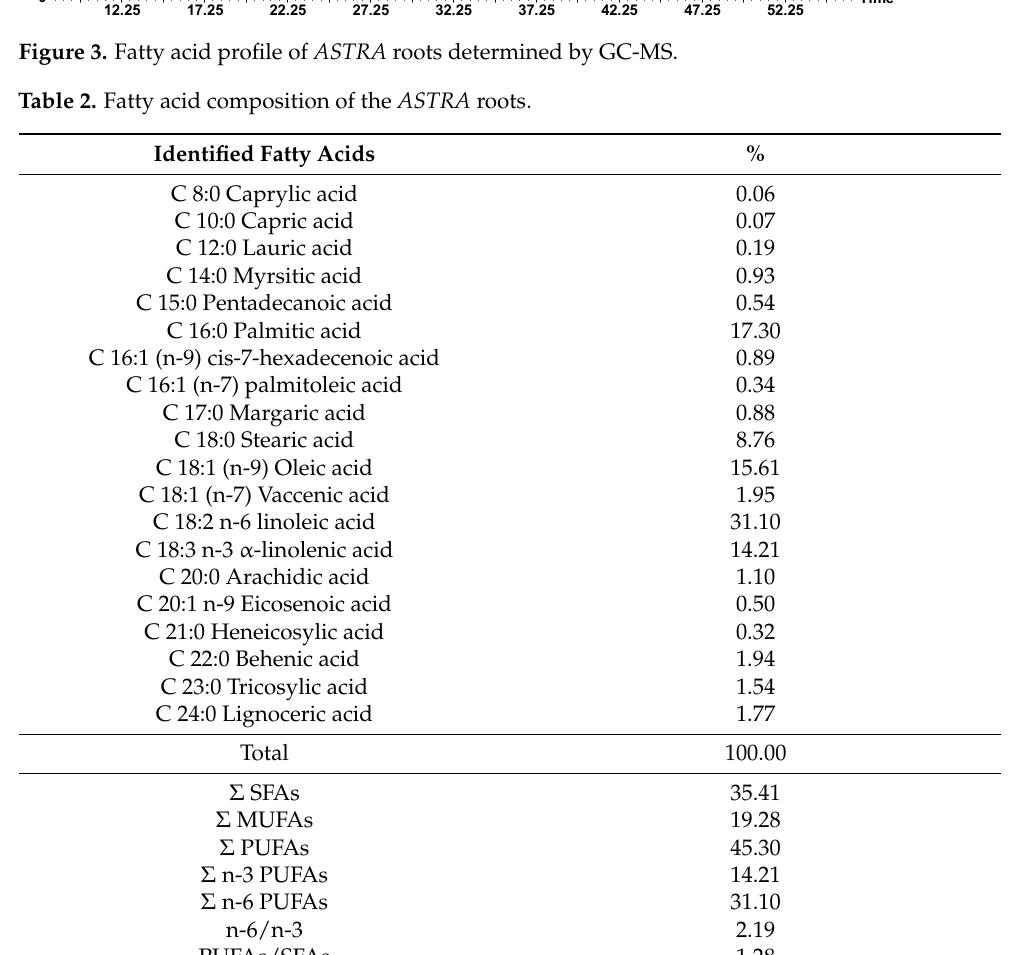
Table 2. Fatty acid composition of the ASTRA roots.